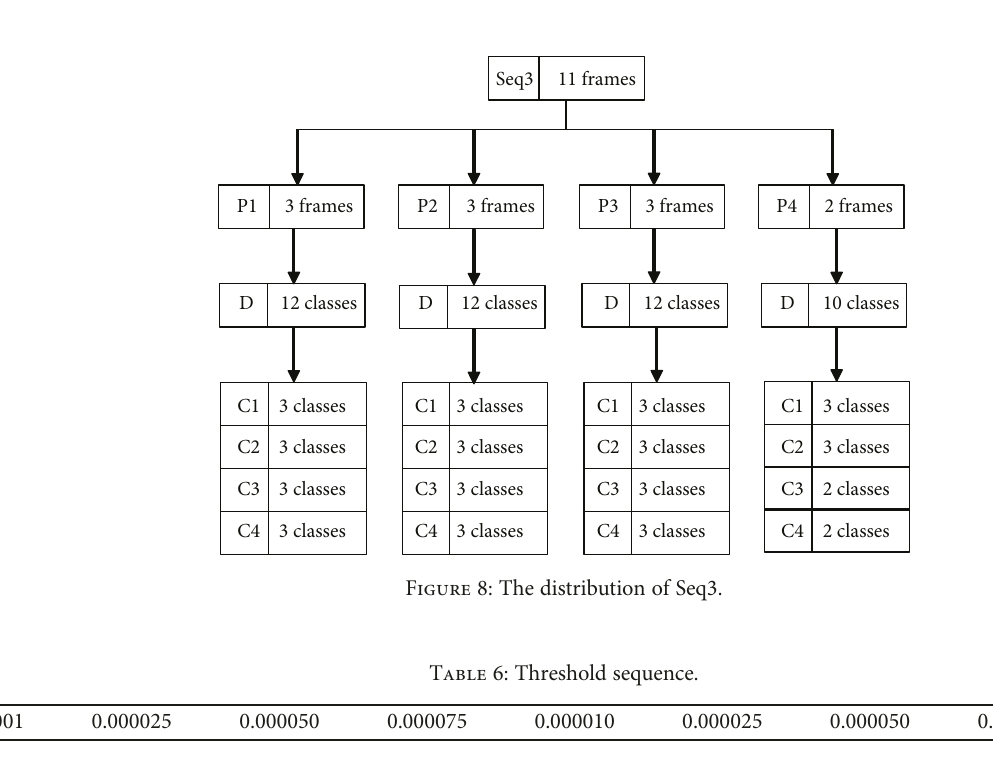
Figure 7: The distribution of